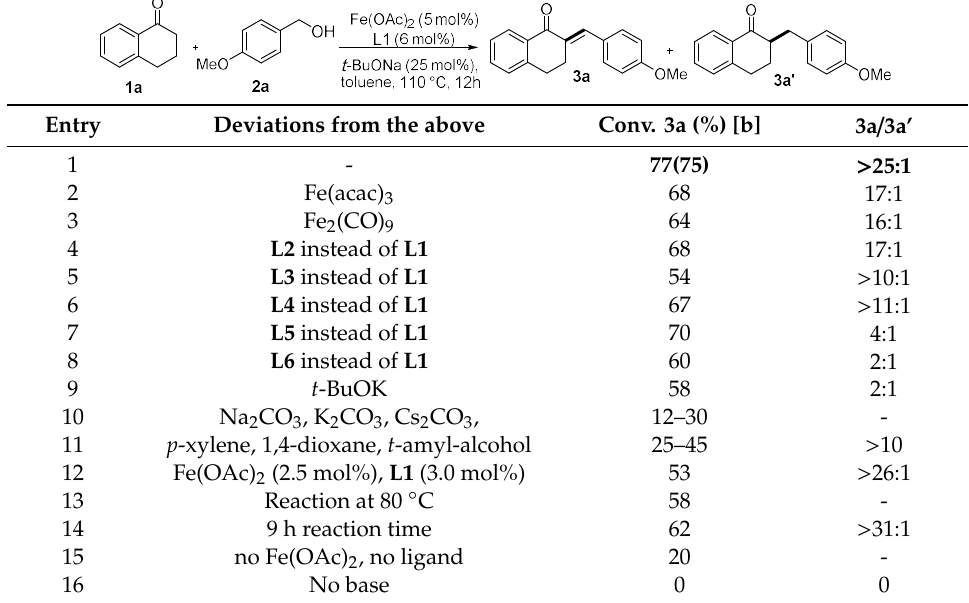
Molecules 2020 , 25 , x FOR PEER REVIEW carbonate and phosphate bases proved less efficient for such transformation (Table 1, entries 9, 10 and SI Table S3).